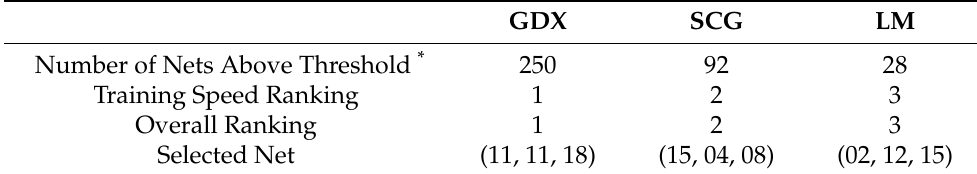
Table 3. Comparison of the performance of the nets trained with three different algorithms (GDX, SCG, LM) according to the correlation coefficients and RMSDs between GOLD RO-VERs and ML